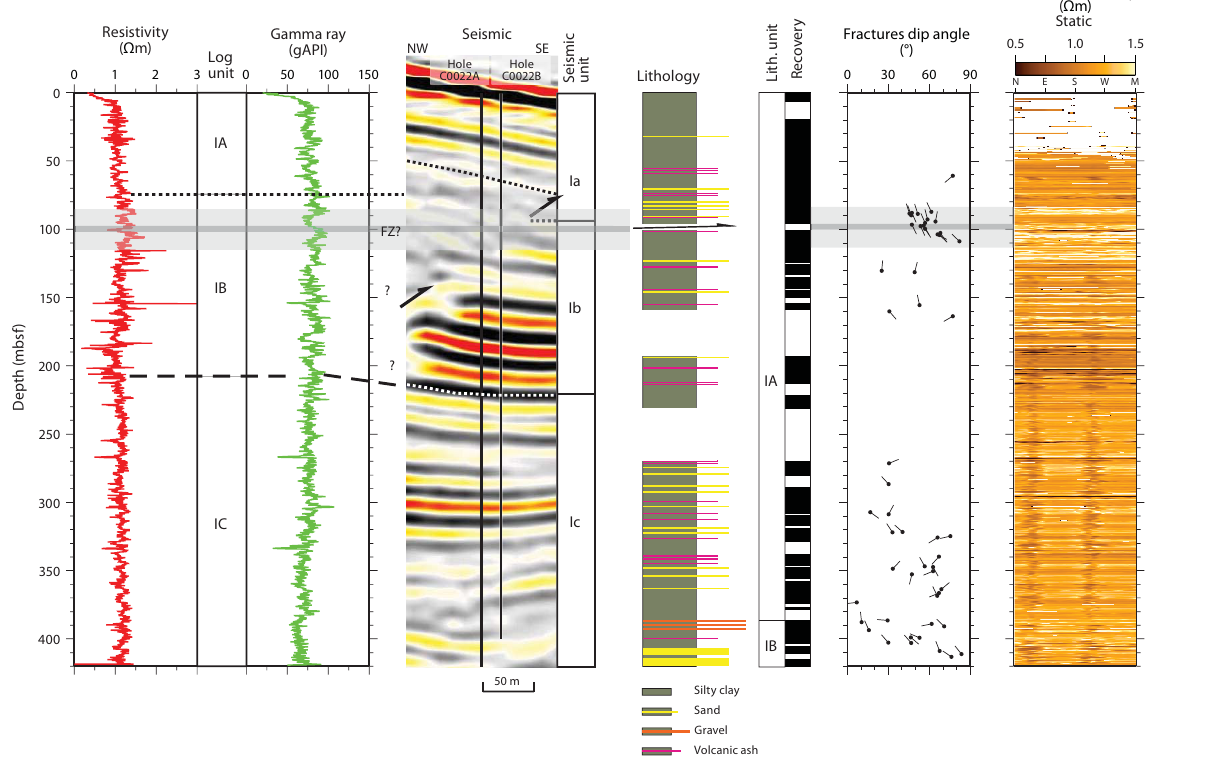
Figure 10. Core-log-seismic integration at Site C0022: LWD data and seismic data from In-line 2315 (Kumano 3-D PSDM volume; Moore et al., 2009) with seismic units defined by Kimura et al. (2011), lithology and lithologic units, fracture dips, and medium button static resistivity. Dashed and dotted black lines show correlations (“?” = tentative) between the di ff erent data sets. Shaded box highlights tip of the splay fault zone (FZ) and wider deformation zone, identified from fractures in resistivity images and shear zones in